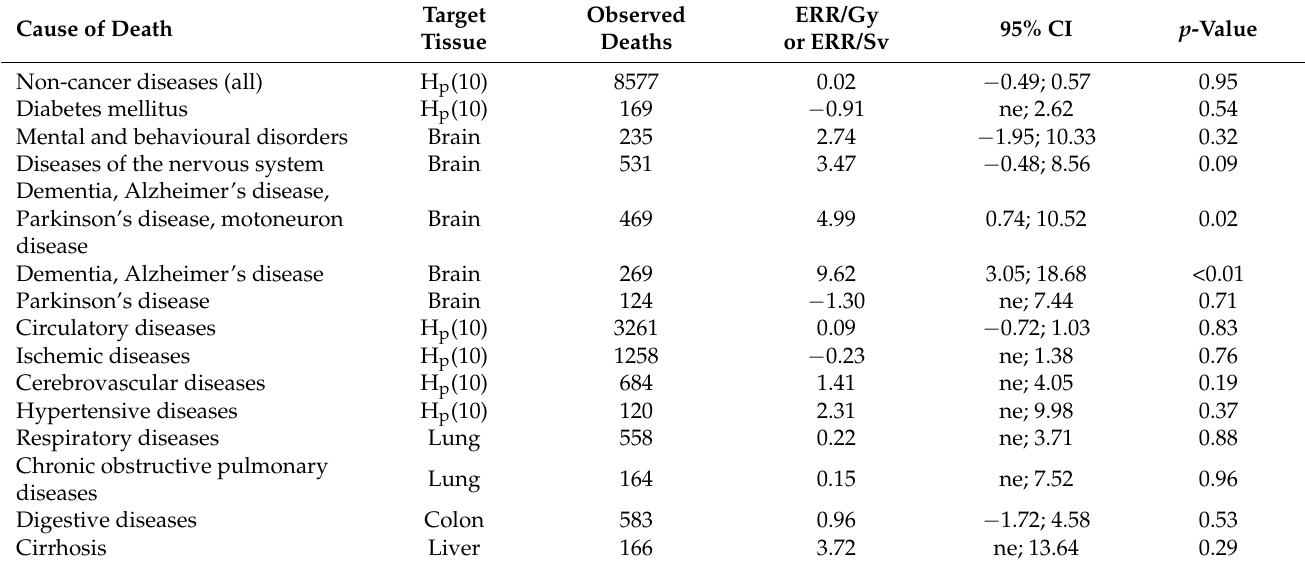
Table 4. Excess relative rates * (ERR) of death from non-cancer diseases per unit (in Gray or Sievert) of 10-year lagged cumulative dose absorbed to target tissues (in Gy or Sv) in males only, SELTINE cohort, period